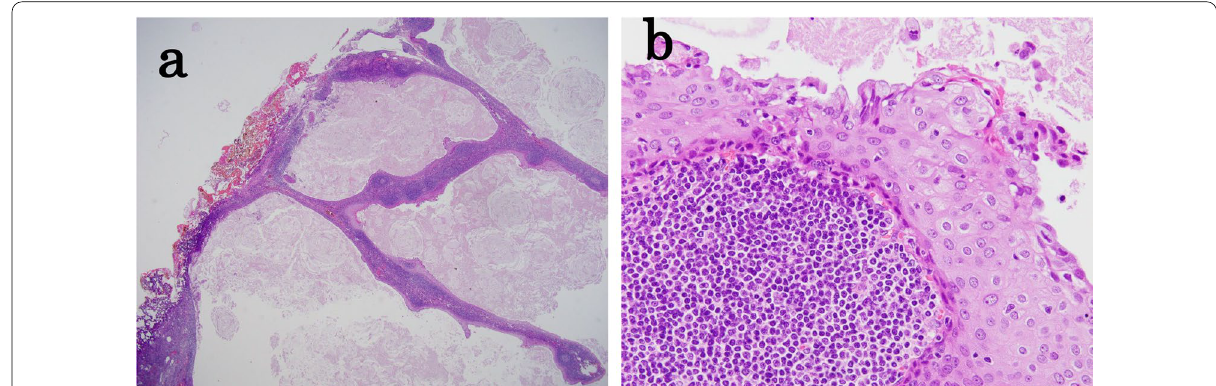
Fig. 4 Microscopic pathological findings. a The multilocular cyst was segregated by a band of lymphoid tissue (H&E staining; was lined with stratified squamous epithelium and mucinous cells, and the cystic contents were keratinized (H&E staining; and